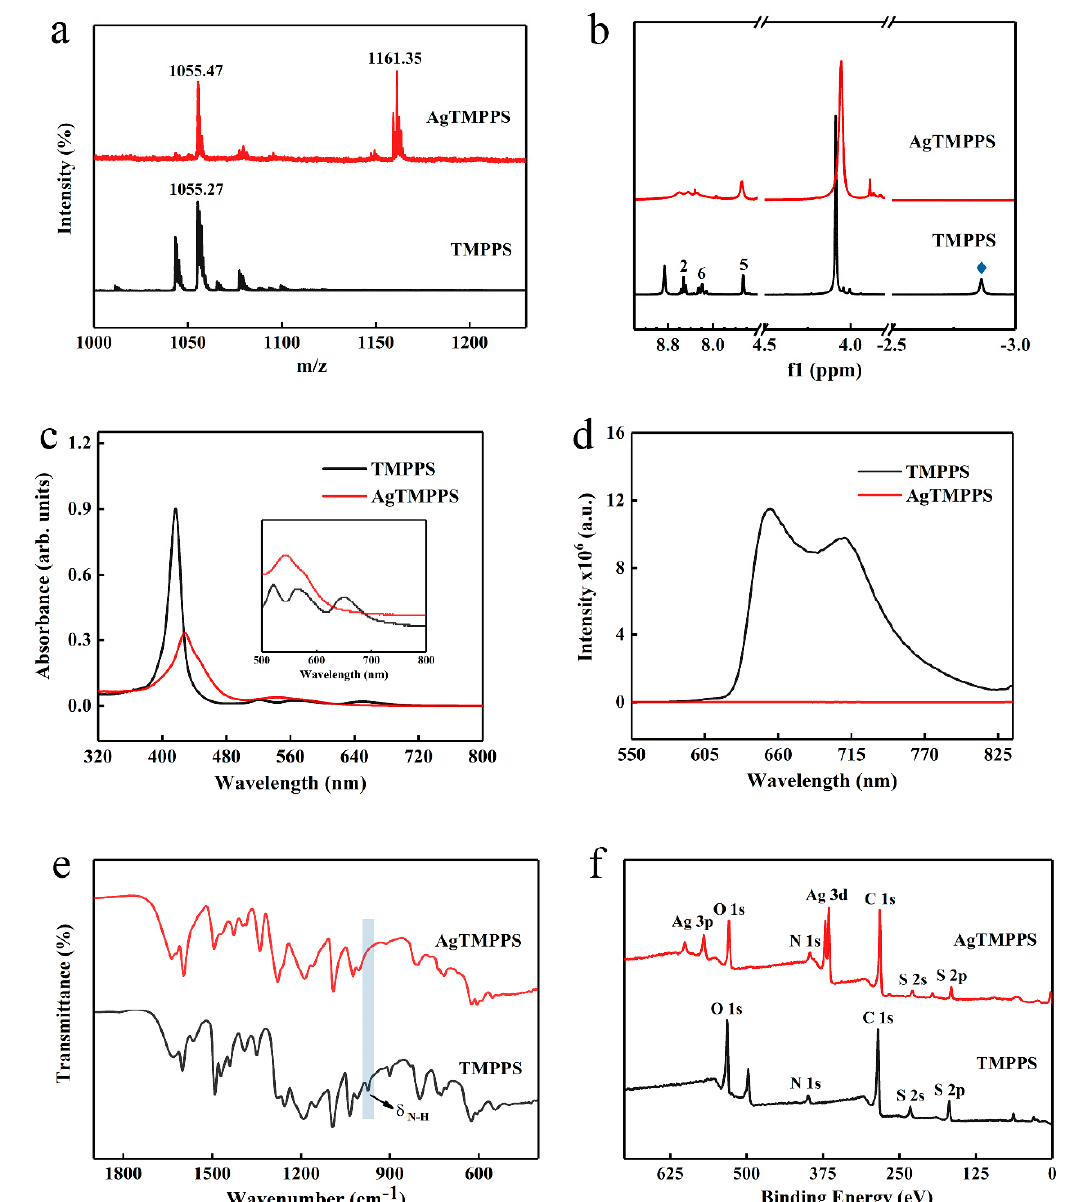
Figure 2. Characterization of TMPPS and AgTMPPS. ( a ) MALDI-TOF mass spectrum of TMPPS and AgTMPPS in ethanol. ( b ) 500 MHz 1 H NMR spectrum of TMPPS and AgTMPPS. The number and blue rhombus represent the proton signals in different chemical environments (Figure 1a). ( c ) UV-vis absorption spectra of TMPPS and AgTMPPS in water. ( d ) Fluorescence emission spectra of TMPPS and AgTMPPS in water ( λ ex = 420 nm). ( e ) FT-IR spectra of TMPPS and AgTMPPS. ( f ) XPS survey scan spectra of TMPPS and AgTMPPS.